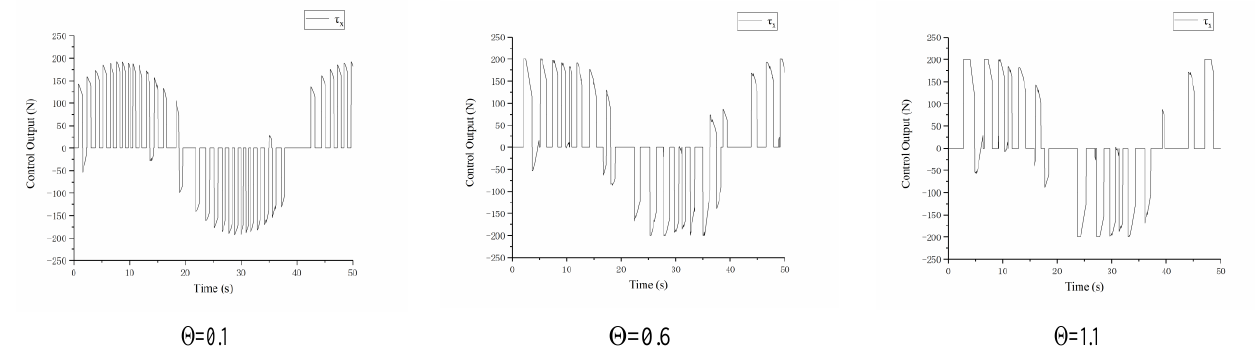
Figure 9. Control output of PRTC scheme.